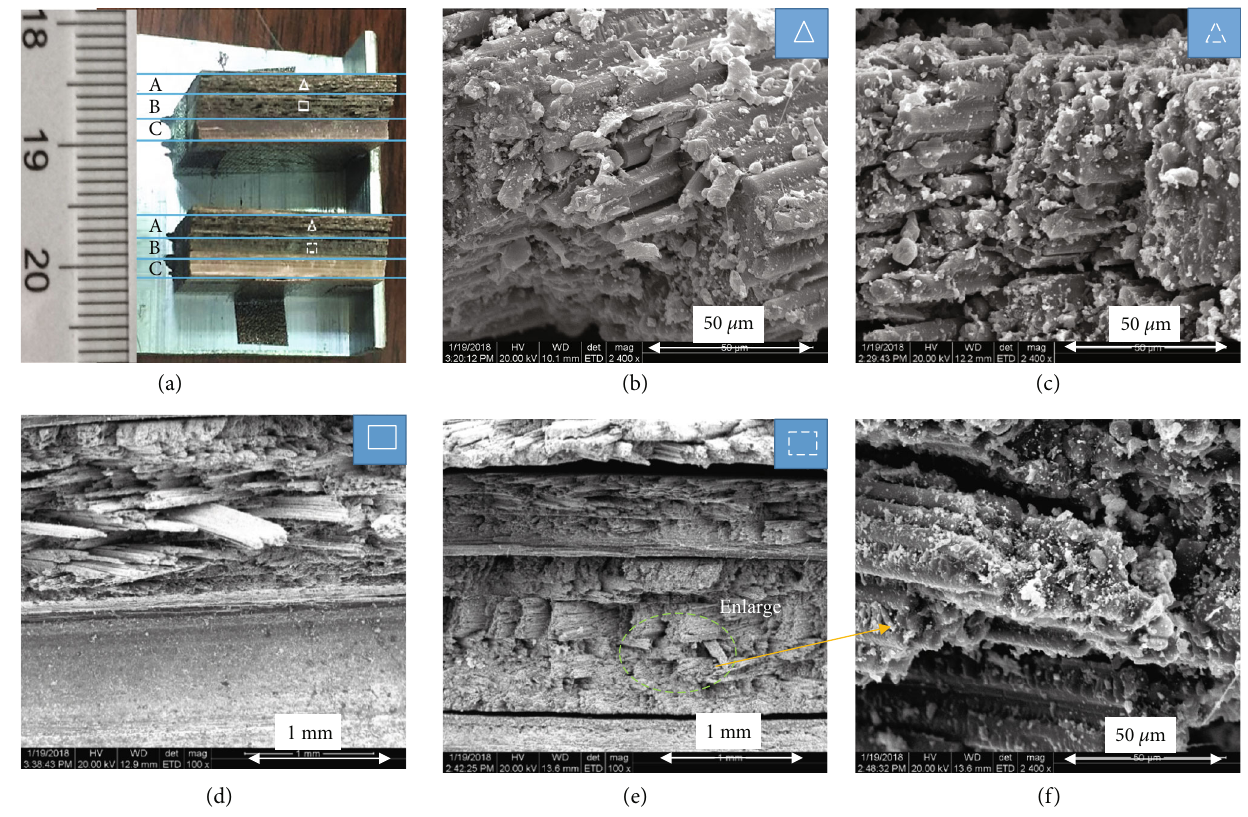
Figure 7: Cutting specimens and SEM micrographs. (a) Cutting specimens for SEM analysis. (b, c) Shear brittle fracture of fi bers. (d – f) Tensile failure. Indicators A, B, and C represent the region away from weakened groove, the region near weakened groove, and the weakened groove, respectively.